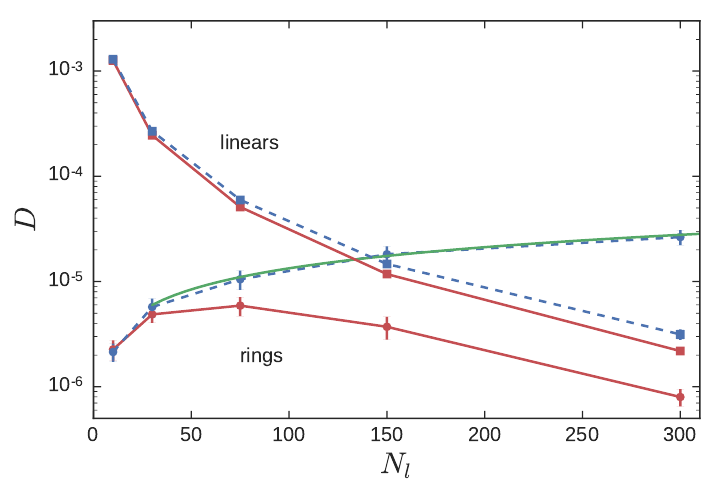
Figure 5. The diffusivity of N r = 300 probe RPs (circles) in LP (squares) matrix, as N l is varied between 10 and 300. The linear fraction φ l is held fixed at 0.9. Red symbols connected with solid lines represent NC simulations, while blue symbols and dashed lines represent CX simulations. The solid green line is the fitting function 6.2 × 10 − 7 N 2/3 l